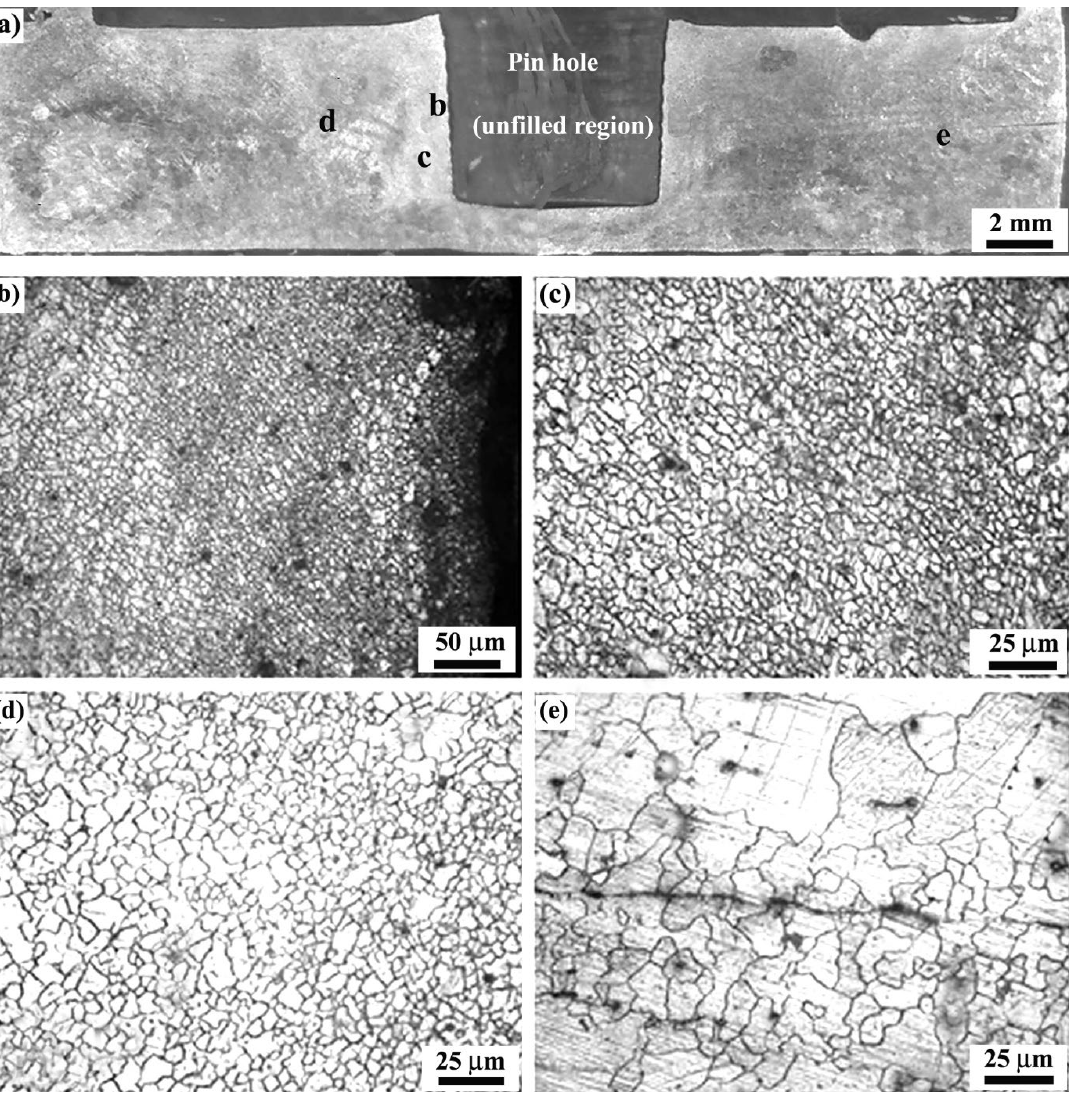
Figure 2. Macrostructure and microstructures of various regions in C-FSSW joint. ( a ) A typical macrograph of the C-FSSW joint. ( b ) and ( c ) SZ, ( d ) TMAZ ( e ) BM microstructures in C-FSSW joint.